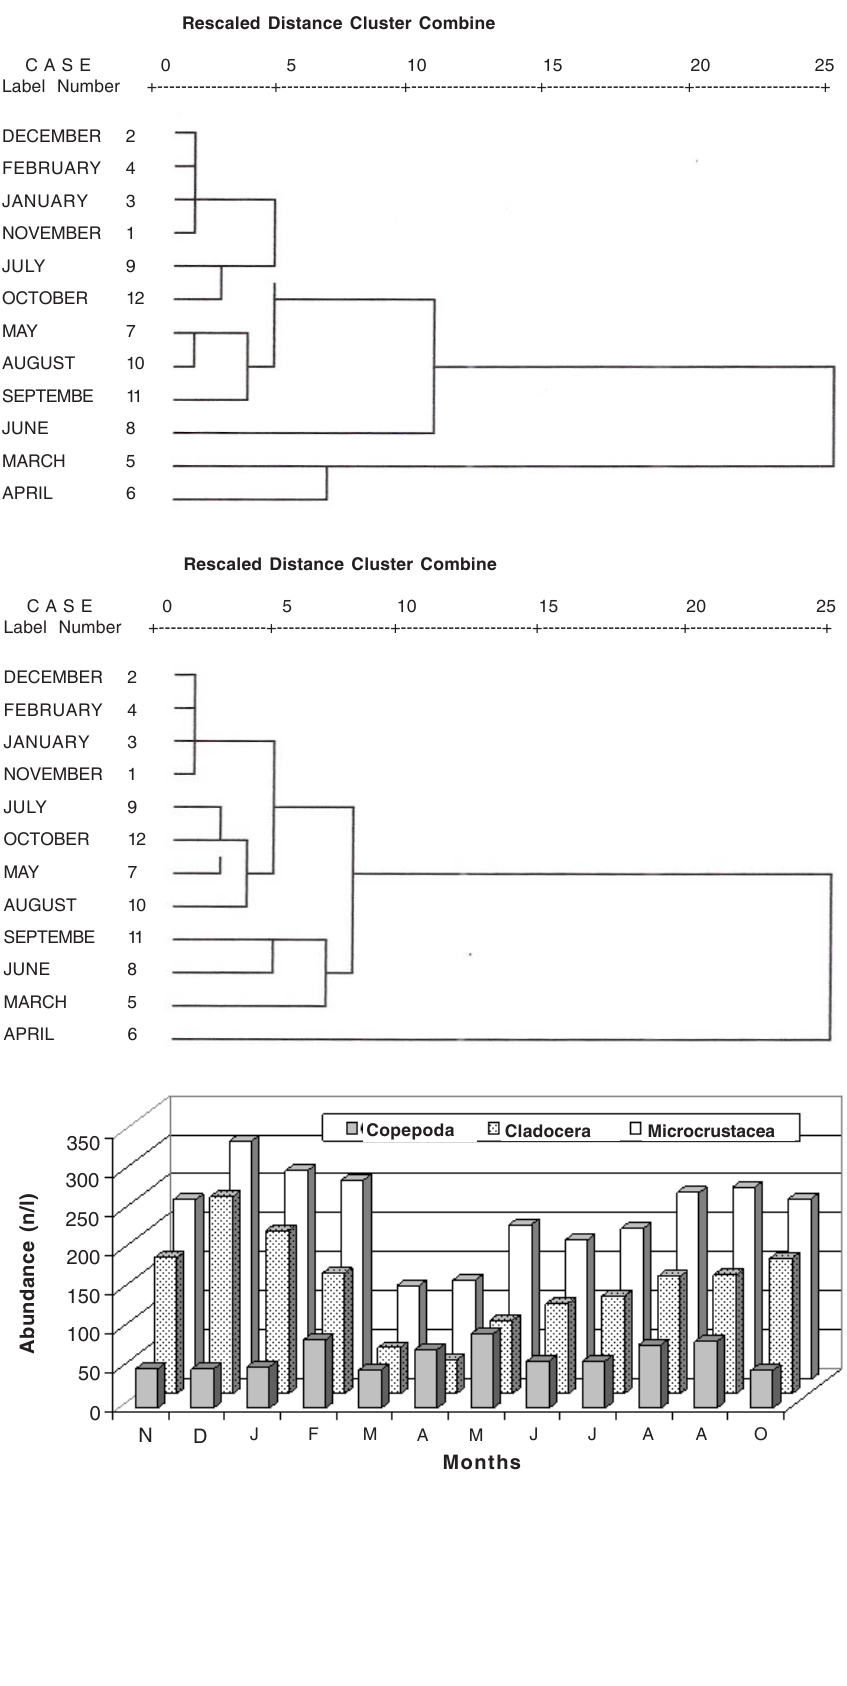
Figure 5. Monthly variations in abundance of